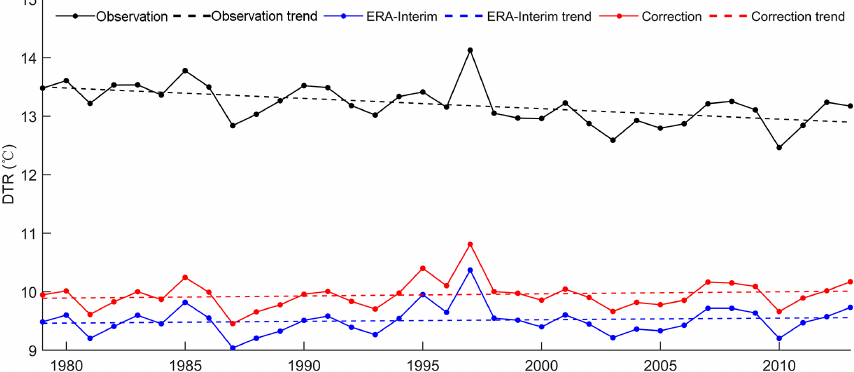
Figure 12. Temporal variations of DTR from observation, original ERA-Interim and correction temperatures for the 24 sites in 1979–2013.